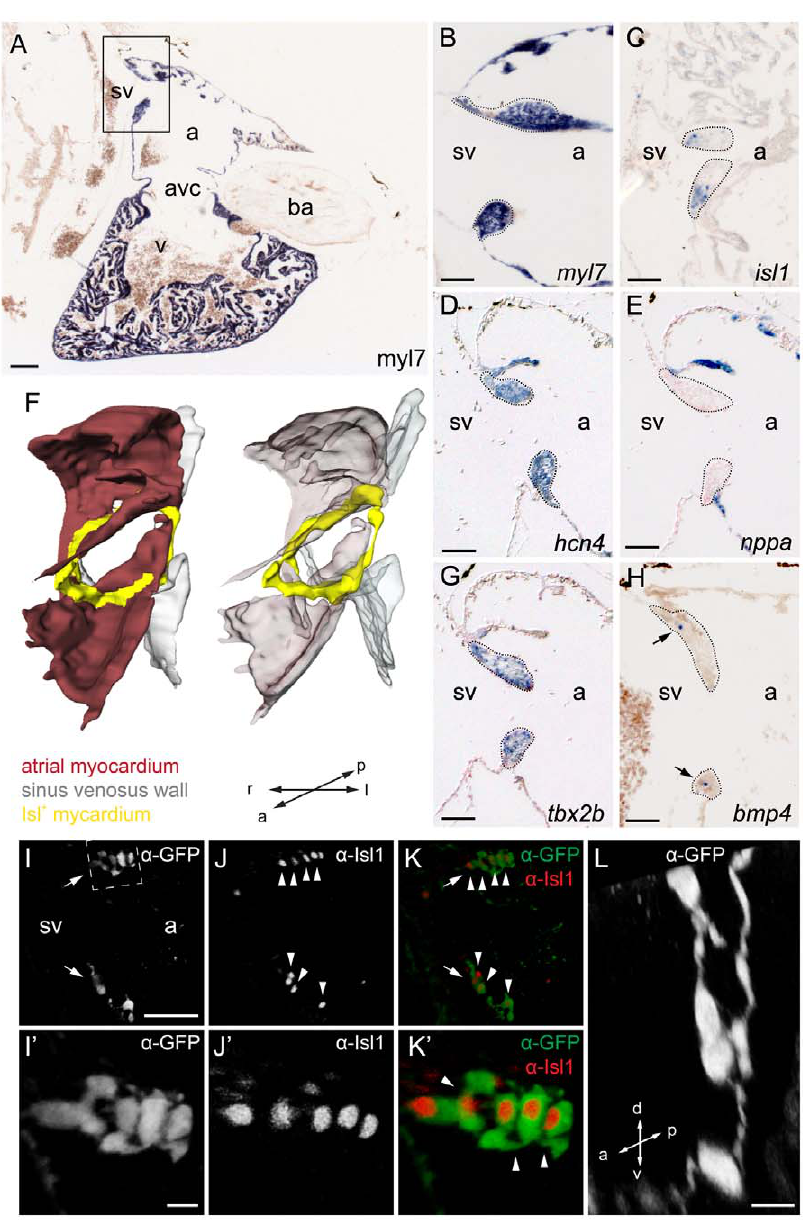
Figure 3. Molecular characterization of the adult isl1 expression domain. ( A–E,G,H ) Section in-situ hybridizations on adult wild-type zebrafish hearts. Probes are indicated in the panels. (A) 4-chamber view of a sagittal section through zebrafish heart labeled with the myocardial marker myl7. The box indicates the region shown enlarged in panels B–E,G,H. Demarcated areas (C) indicate isl1 expression in the tbx2b + hcn4 + nppa- myocardium at the base of the valves surrounding the sinoatrial junction. BMP4 signal is pointed at in the valves by arrowheads in (H). ( F ) 3D reconstruction of the sinoatrial junction. isl1 (yellow) is expressed around the entire sinoatrial junction, forming a ring-like structure. ( I–L ) Reconstruction of a confocal scan through a sagittal section of the inflow region of adult Tg(isl1BAC:GalFF; UAS:GFP) transgenic zebrafish heart. Fluorescent antibody labeling for GFP (shown in grey (I, I’, L) or green (K, K’)) and for Isl1 (shown in grey (J, J’) or red (K, K’)). GFP + /Isl1 + cells were found in bilateral populations at the sinoatrial junction (arrows). (I’–K’) Enlargement of the GFP + /Isl1 + cells at the dorsal rim of the inflow tract (indicated with dashed box in (I)). Nuclei of GFP + cells were positive for Isl1 (arrowheads). (L) Enlargement of GFP + cells (transverse section) shows a string of contiguous cells. a, atrium; avc, atrioventricular canal; ba, bulbus arteriosus; sv, sinus venosus; v, ventricle; l, left; r, right; a, anterior; p, posterior; d, dorsal; v, ventral. Scale bars represent 50 m m (A–G, I–K) or 10 m m (I’–K’,L). doi:10.1371/journal.pone.0047644.g003 the activation sequence and electrophysiological characterization functional pacemaker of the adult zebrafish heart is organized as of single Isl1 + myocytes demonstrated the presence of pacemaker a ring around the venous pole and (3) expression of Isl1 in the activity in the Isl1-expressing cells (Fig. 4). Altogether, our data pacemaker cells of the adult heart is conserved from fish to human. allow us to establish that (1) Isl1 is the first identified molecular Cells pertaining to the primary pacemaker structure in zebrafish marker for pacemaker cells in the zebrafish heart, (2) the and mammals share a number of molecular markers, relative